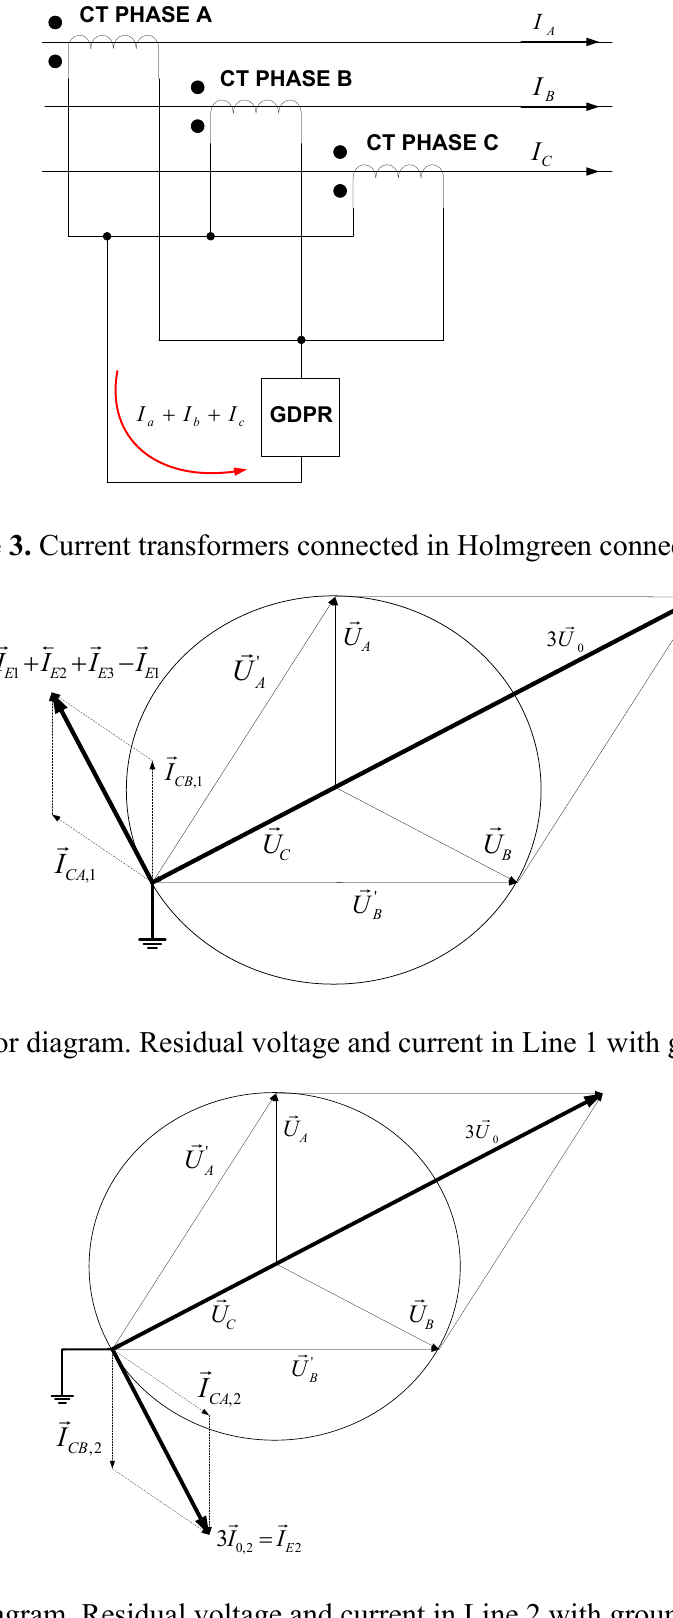
Figure 5. Vector diagram. Residual voltage and current in Line 2 with ground defect in Line